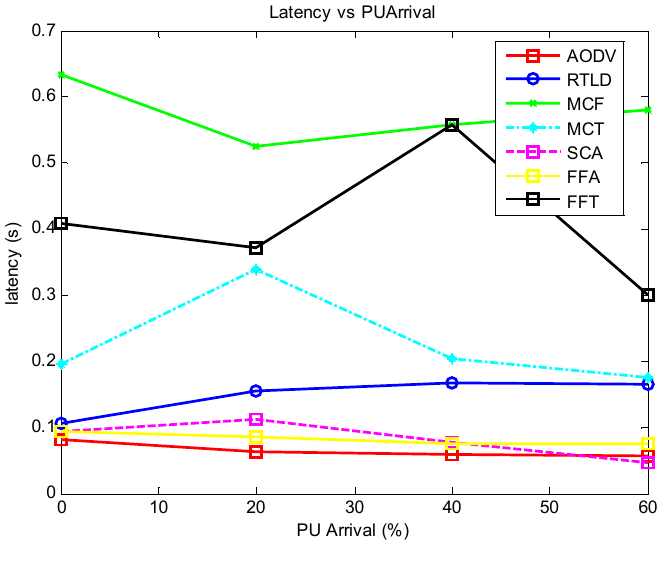
Figure 3. Latency performance of all protocols versus primary user